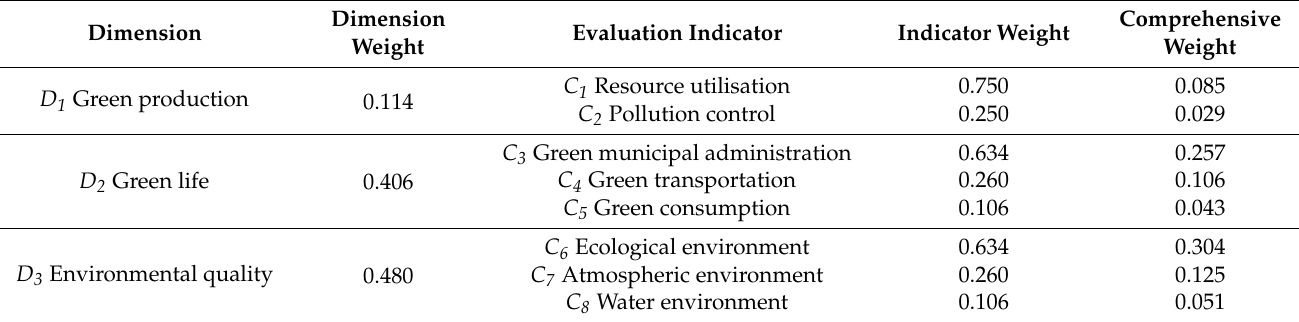
Table 9. Results of weight analysis of evaluation factors for the level of sustainable development in green cities.